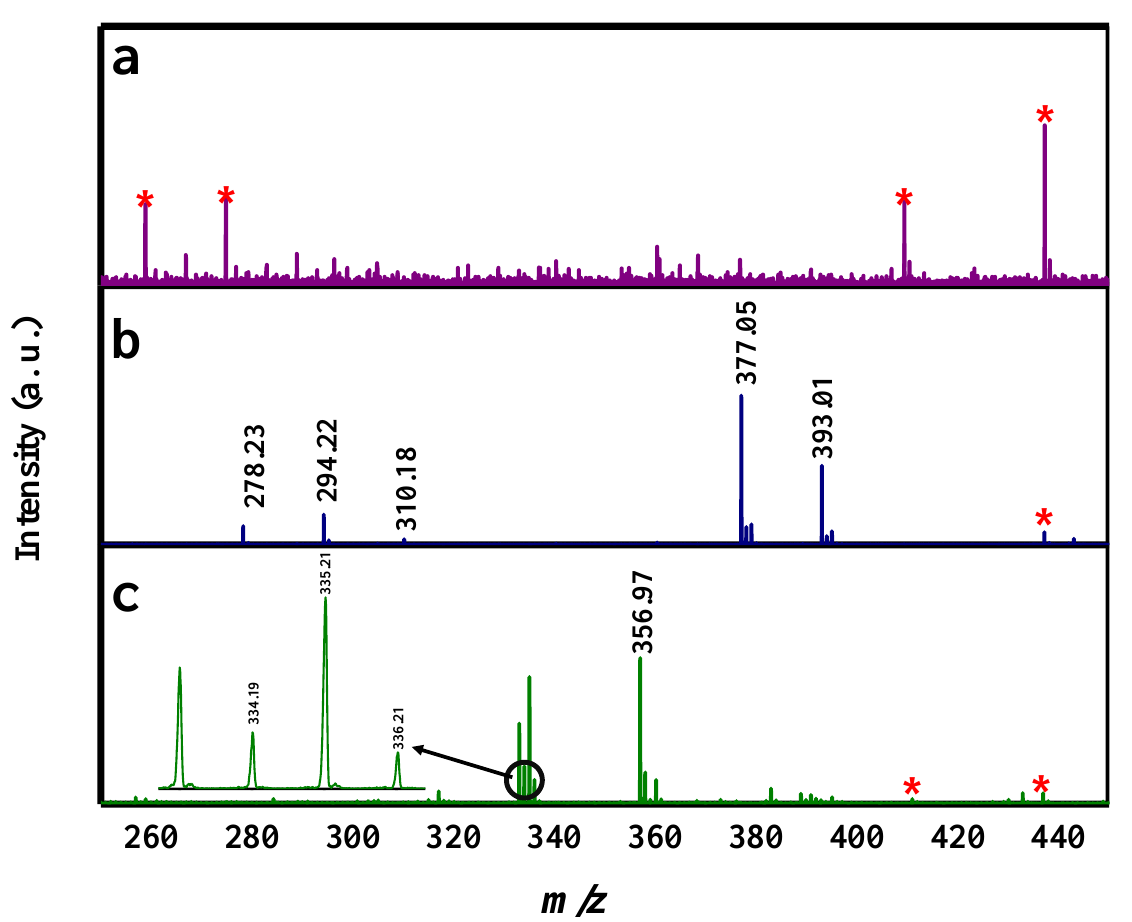
Figure 6. SALDI-MS spectra using FeNi MANPs as substrate. ( a ) control human serum sample. ( b ) dimethamtetryn, napropamide, thiodicarb (the red asterisks point to possible presence of human serum compounds in sample), and ( c ) strychnine in human serum. Table 3. Poisons detected, ion formed, m/z , average intensity, %RSD, and LOD in human serum.